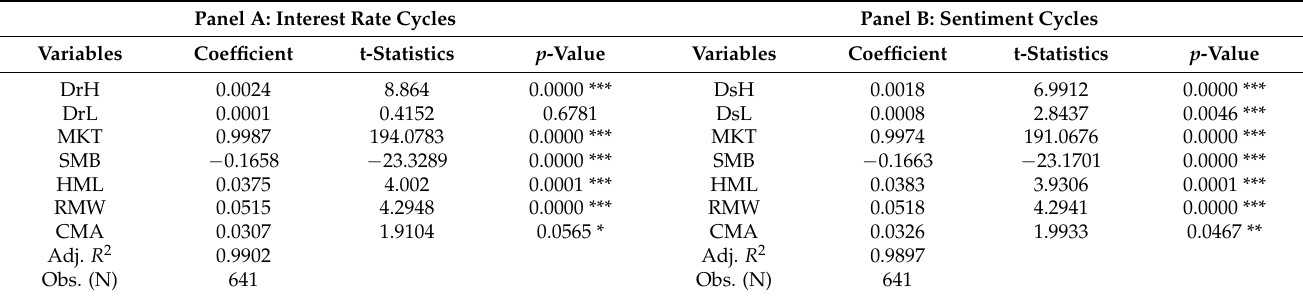
Table 4. Interest rate cycles and sentiment cycles on stock returns. Panel A presents the five-factor adjusted returns of the S&P 500 in interest rate cycles for Equation (6); Panel B presents the five-factor adjusted returns of the S&P 500 in sentiment cycles for Equation (7). The median of long-term real interest rate is 2.42%, greater than (less than) the median defined as a high-interest rate (low- interest rate) cycle; the median of market sentiment is 0.03, greater than (less than) the median defined as a high-sentiment (low-sentiment) cycle. All t-statistics are based on the Heteroskedasticity- Autocorrelation-Consistent standard errors. *, **, and *** denote significance at the 10%, 5%, and 1% levels, respectively.